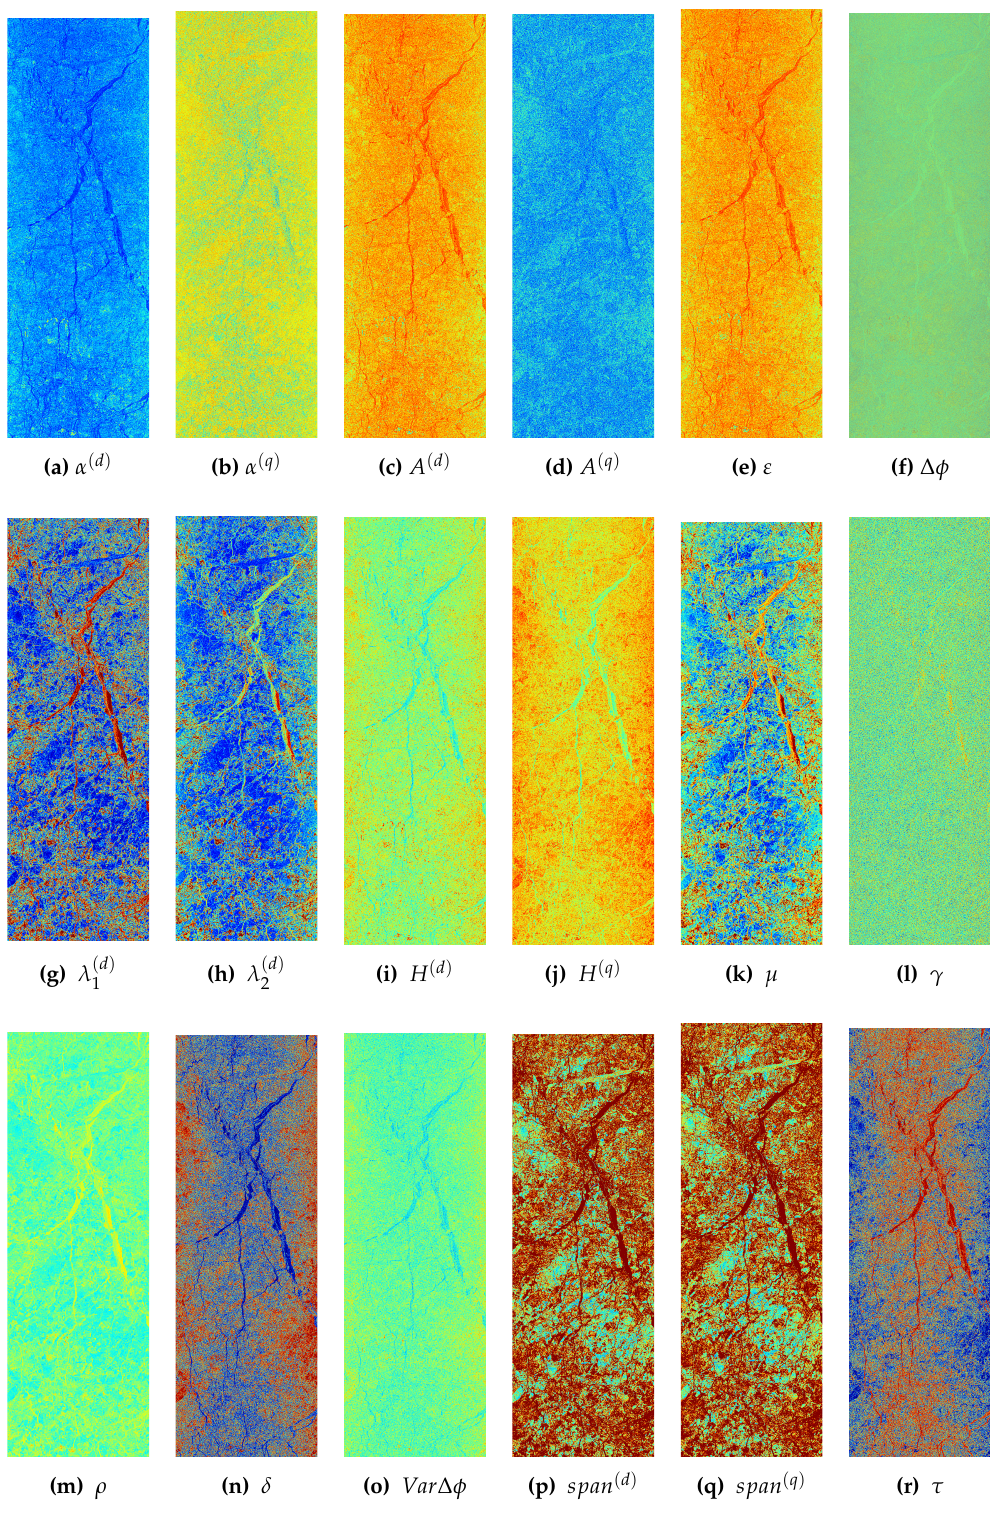
Figure 2. Images of different features for TS-X 23 April 2015, frame 1: ( a ) α ( d ) ; ( b ) α ( q ) ; ( c ) A ( d ) ; ( d ) A ( q ) ; ( e ) ε ; ( f ) ∆ φ ; ( g ) λ ( q ) span ( q ) ; ( r ) τ